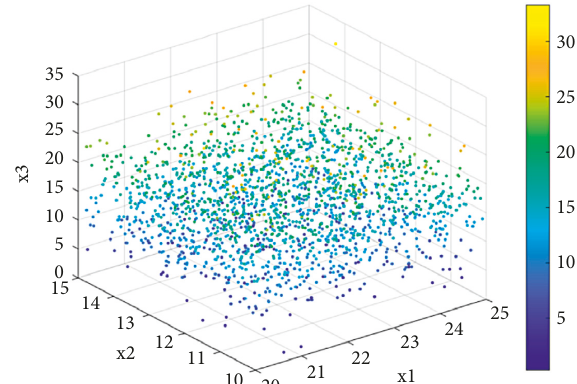
Figure 5: Scatter plot of data in multivariate case.